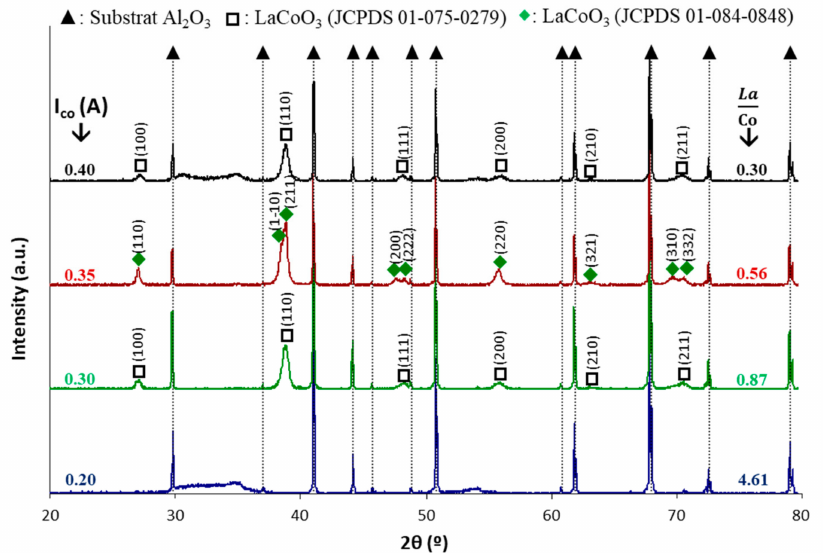
Figure 3. XRD patterns as a function of the atomic composition ratio after calcination treatment at 500 ◦ C for 2 h under